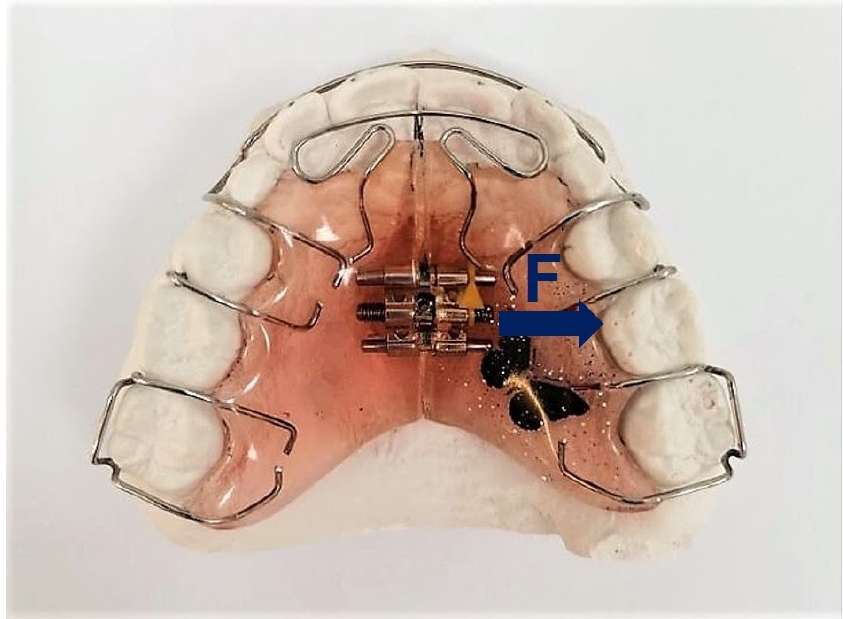
Figure 3. An example of a removable appliance used in patients in the study group. F—forces acting on the dental arches [Own source].